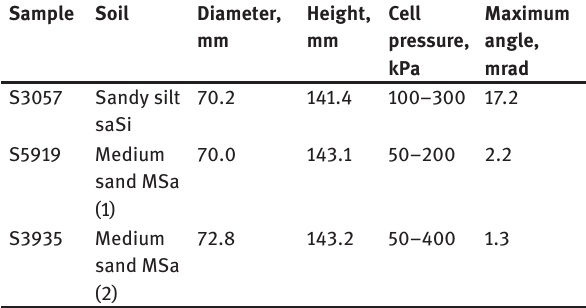
Table 2: Parameters of tested